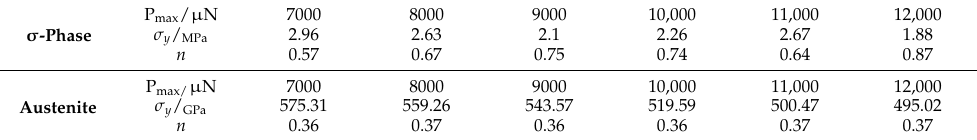
Table 2. Yield strength and hardening index of σ -phase and austenite under different